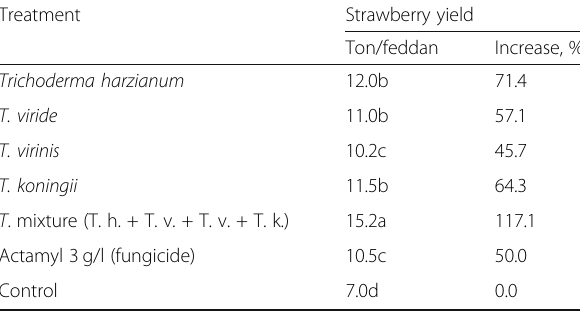
Table 4 Effect of four Trichoderma spp. on strawberry yield under field conditions